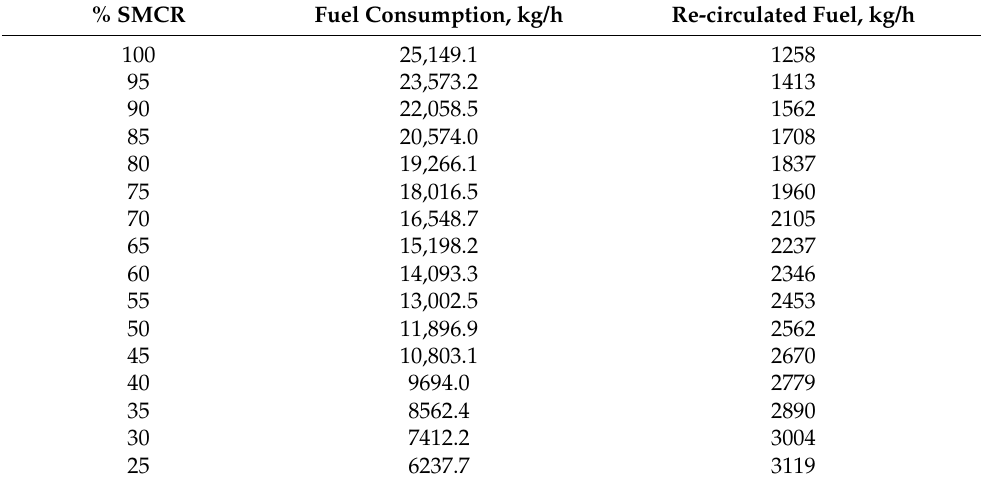
Table 7. Fuel consumption and re-circulated